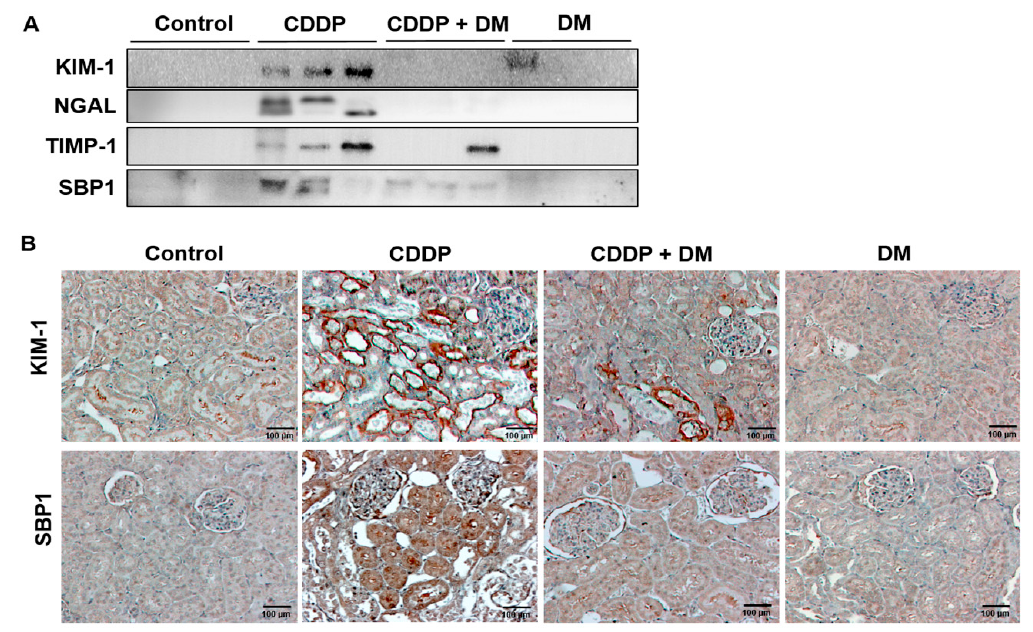
Figure 5. Effect of DM on acute kidney injury biomarkers in CDDP-treated rats. ( A ) Changes in the urinary excretion of KIM-1, NGAL, TIMP-1, and SBP1. The Western blot results represent three separate experiments. ( B ) Immunohistochemical staining of KIM-1 and SBP1 in the kidney of the rat. Magnification ×100.